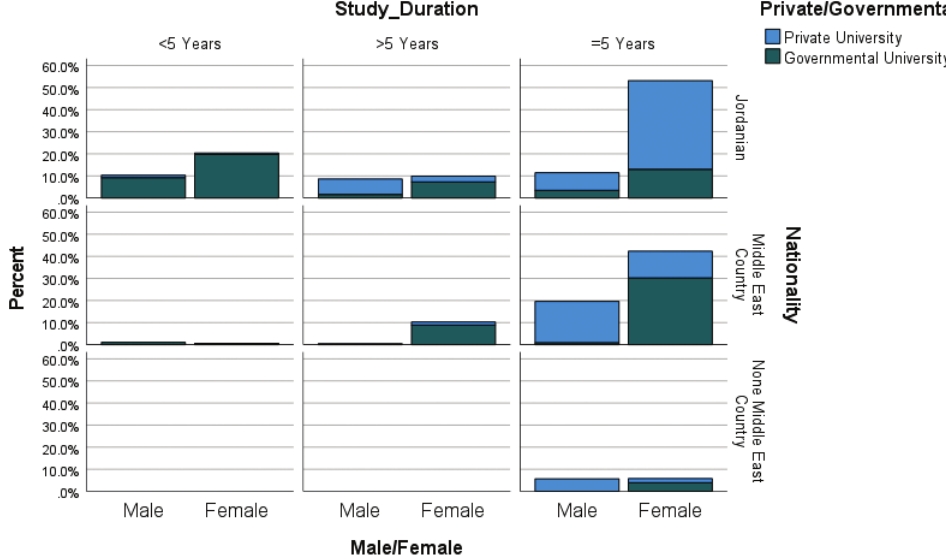
Figure 2. Correlation between Private and Governmental universities with graduates’ nationality and study